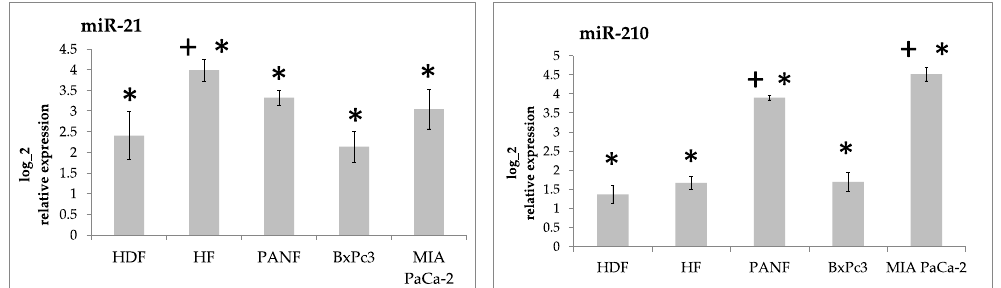
Figure 2. Log2 relative expression intensity of miR-21 and miR-210 in cultured human fibroblasts (HDF and HFs), cancer-associated fibroblasts prepared from pancreatic ductal adenocarcinoma (PANF) and cell lines prepared from this type of tumor (BxPC3 and MIA PaCa-2) compared to the tissue of the normal pancreas. Significant differences between cultured cells and the tissue of the normal pancreas, i.e., two-fold increase at adjusted p -value < 0.05, are marked by asterisks. Statisti- cally significant differences between HDF of ectomesenchymal origin and other cell lines at adjusted p -value < 0.05 are marked by crosses.